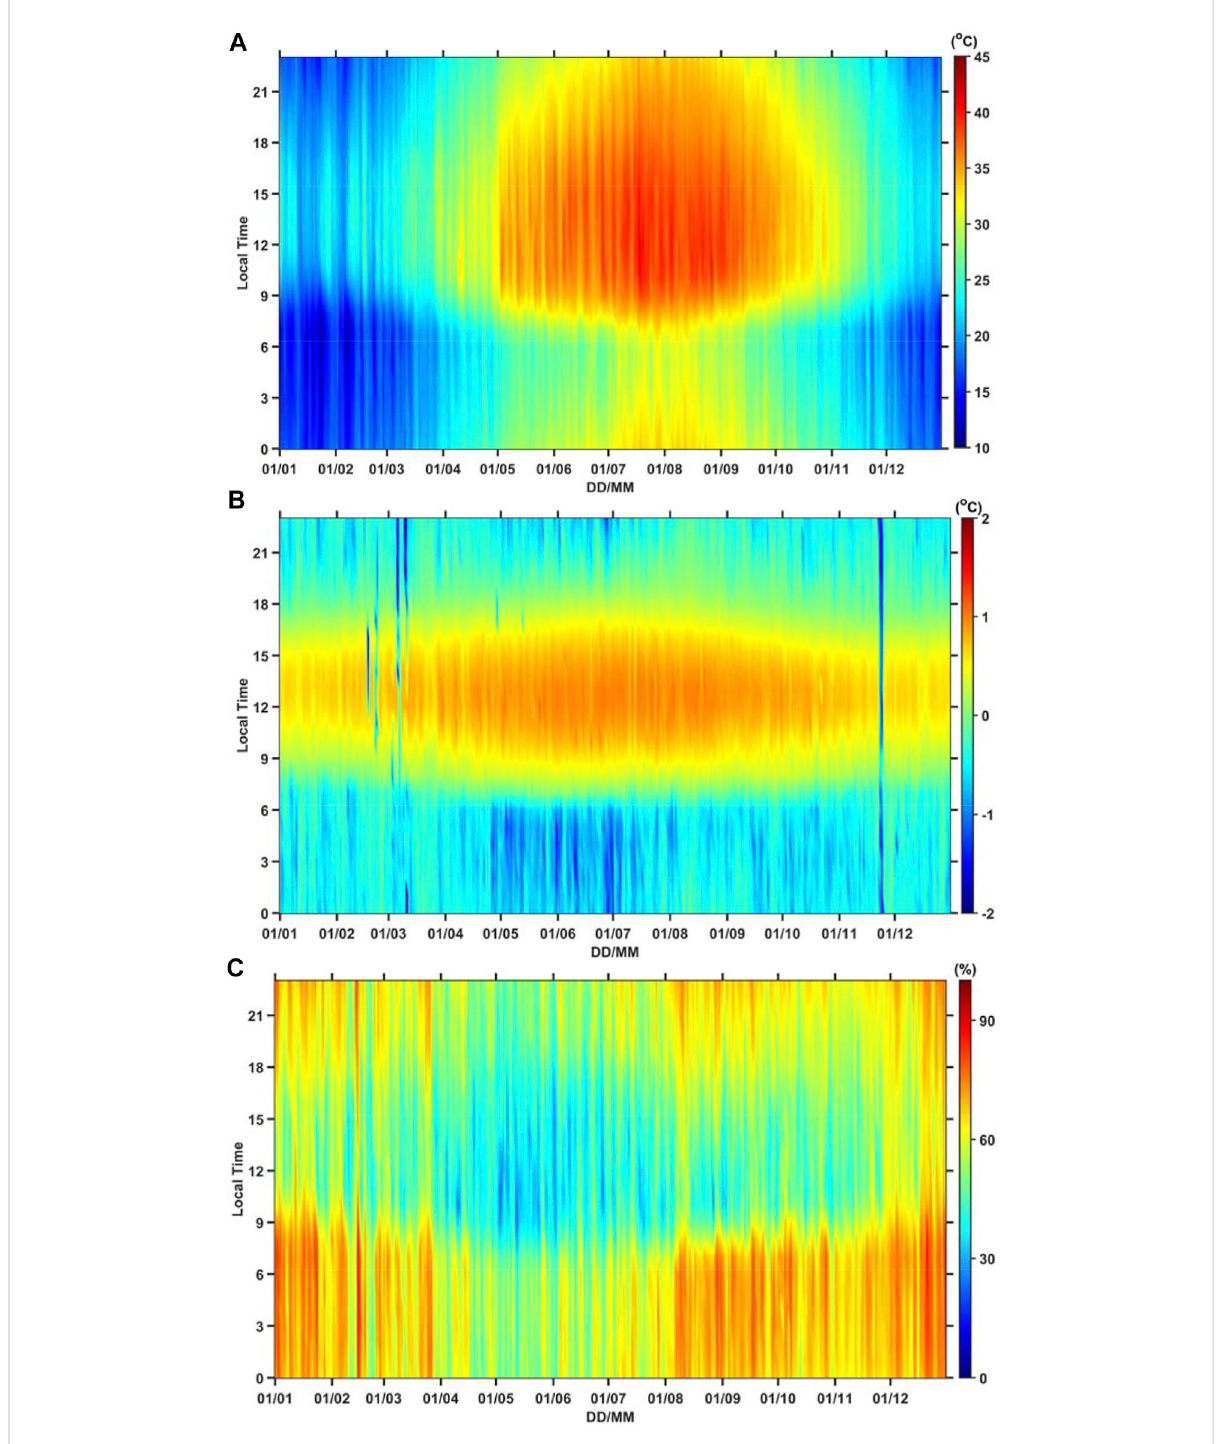
FIGURE 3 Diurnal cycle averaged over 2012 – 2019 for all days of the year for (A) 1.5-m temperature ( ° C), (B) temperature difference ( ° C) between 1.5 and 60 m as an indication of the stability of the near-surface atmosphere, (C) relative humidity (RH) at 1.5-m